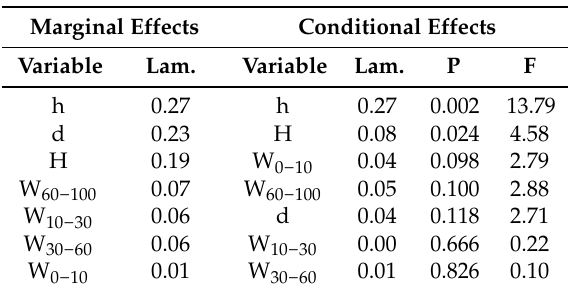
Table 5. Ranking environmental variables in importance in 2005.